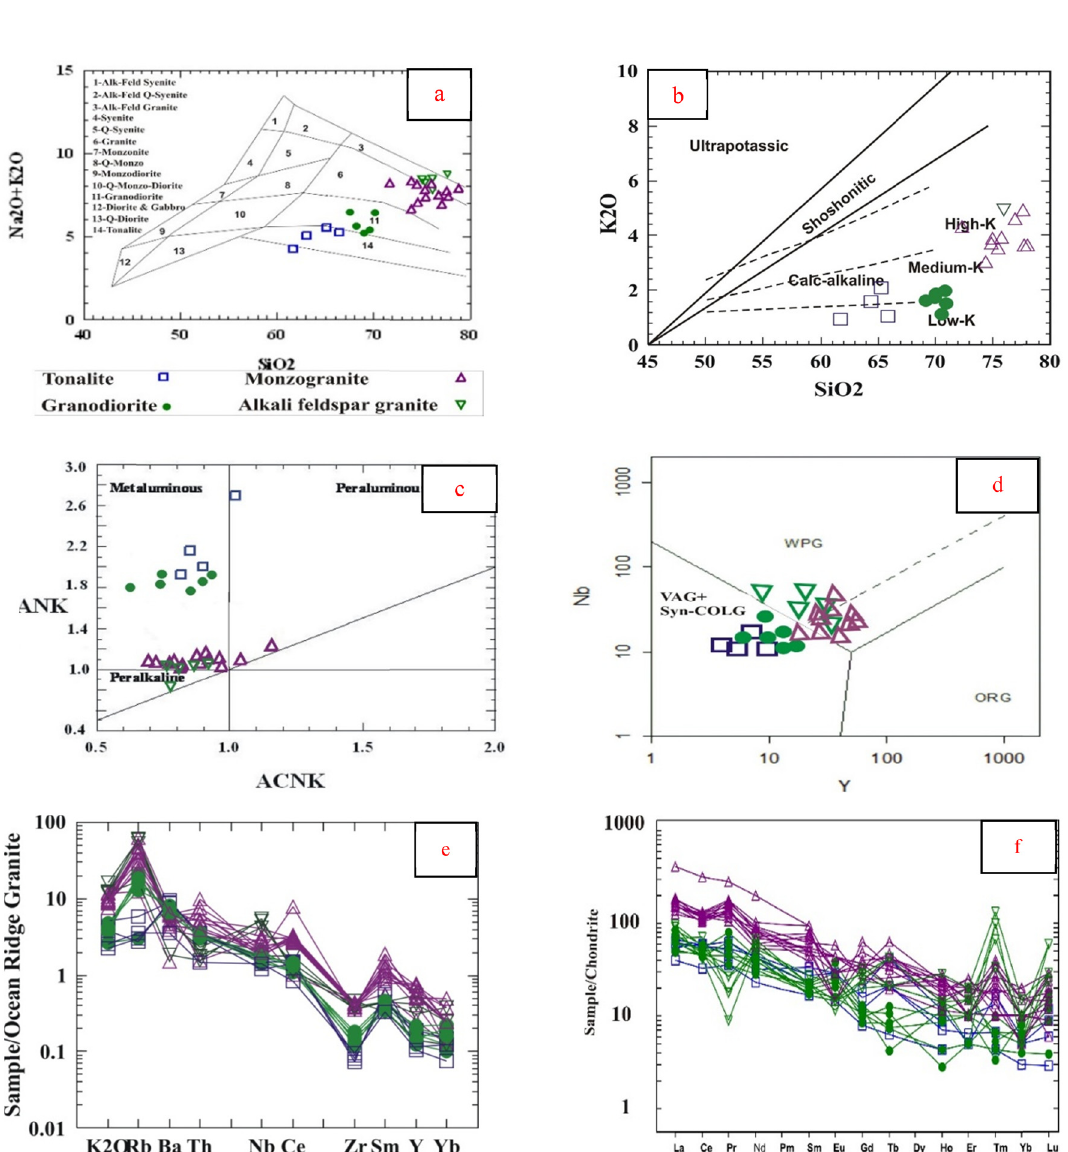
Figure 5: ( a ) Plots of the investigated granites on SiO 2 vs ( Na 2 O + K 2 O ) diagram [ 30 ] , ( b ) K 2 O – SiO 2 showing the medium - to - high K nature of studied granites, calc - alkaline, shoshonitic, and ultrapotassic fi elds ( modi fi ed from ref. [ 31 ]) , ( c ) plots of the investigated granites [ 32 ] . A = Al 2 O 3 , C = CaO, N = Na 2 O, and K = K 2 O, ( d ) plots of the investigated granites on Nb versus Y diagram [ 33 ] . ( e ) ORG - normalization for study granite sand, and ( f ) chondrite - normalized REE diagram [ 34 ] of the study